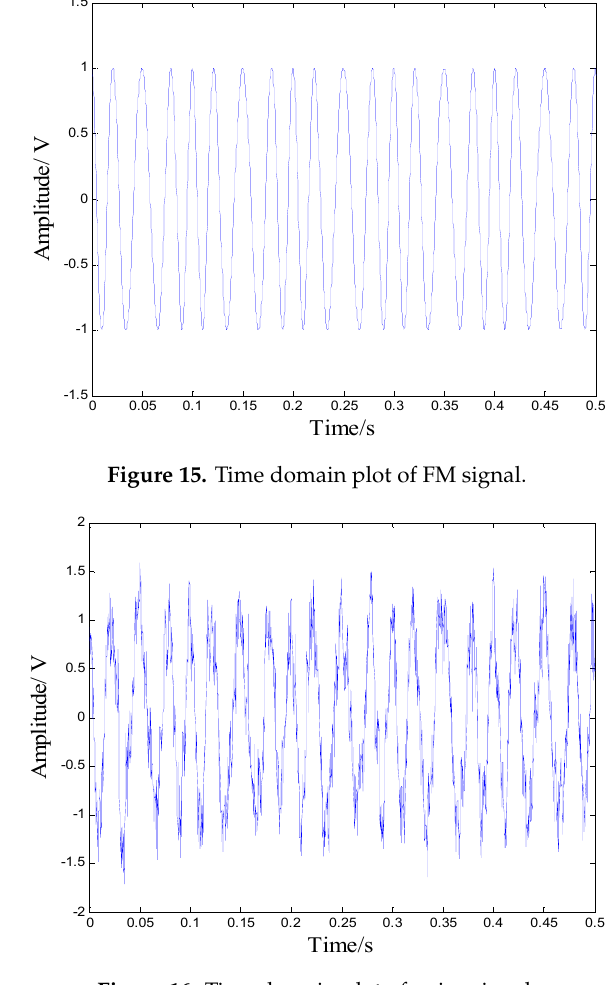
Figure 16. Time domain plot of noisy signal.